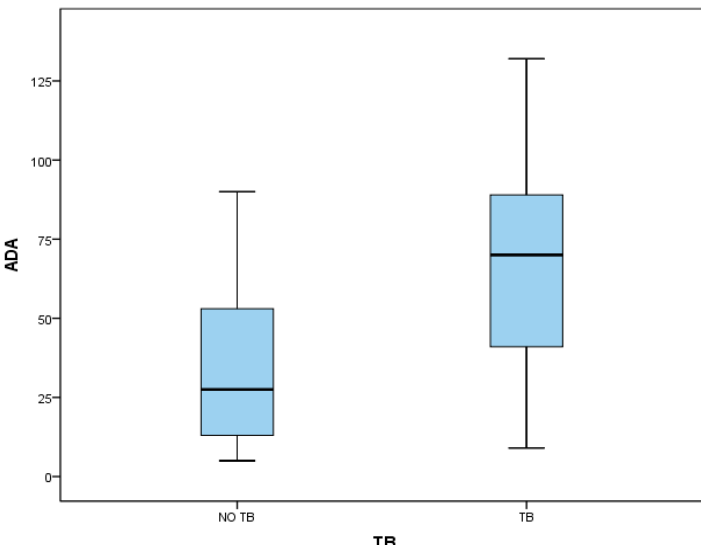
Figure 1. Box plot for ADA value according to final diagnosis. Abbreviations: ADA: adenosine deaminase assay; TB: diagnosis of tuberculosis; NO TB: diagnosis other than tuberculosis. In each box plot, the central horizontal line indicates the median value, and the lower and upper box horizontal lines indicate the 25th and 75th percentiles, respectively. Whiskers above and below the box indicate the 90th and 10th percentiles, respectively.